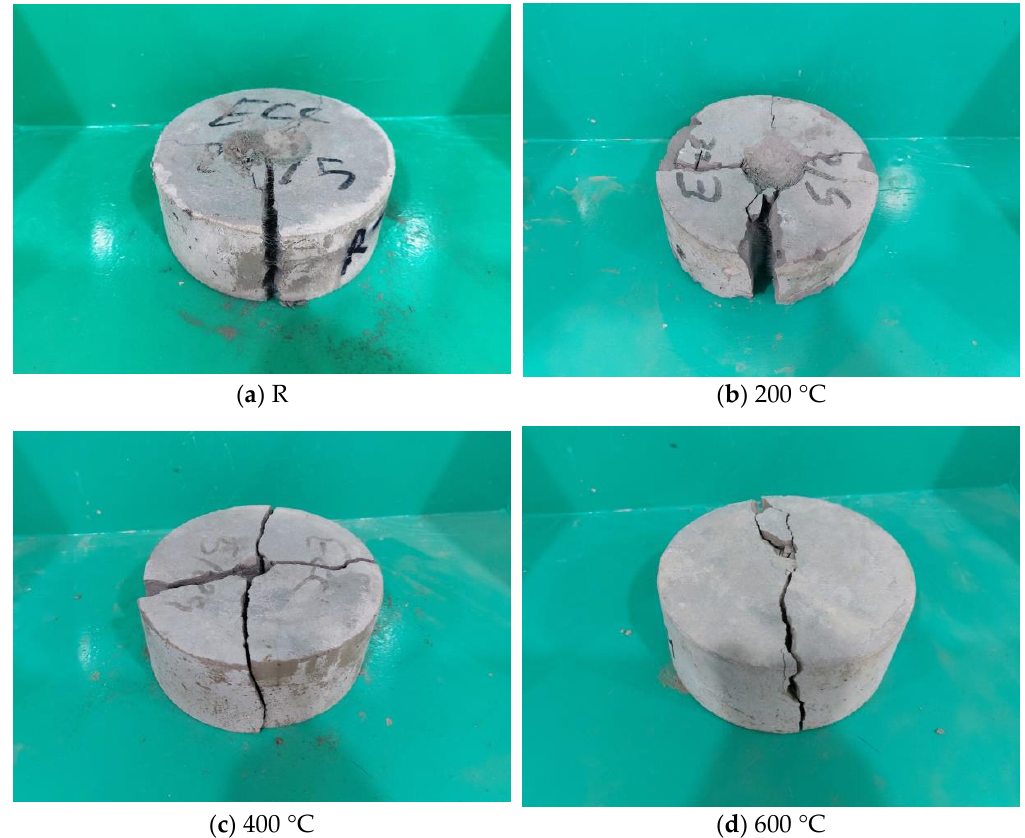
Figure 11. Failure patterns of tested impact specimens heated to different temperatures.